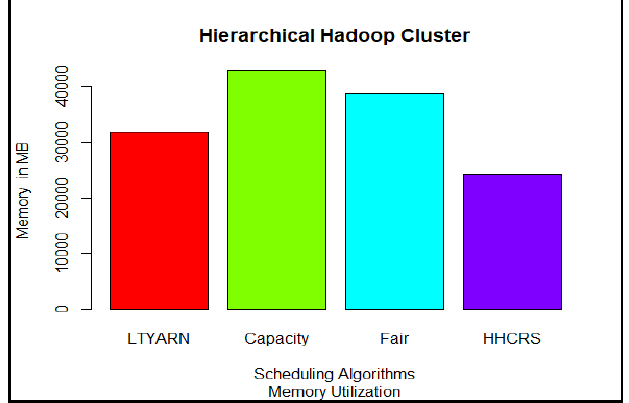
Fig 9: Comparison of Scheduling Algorithms –